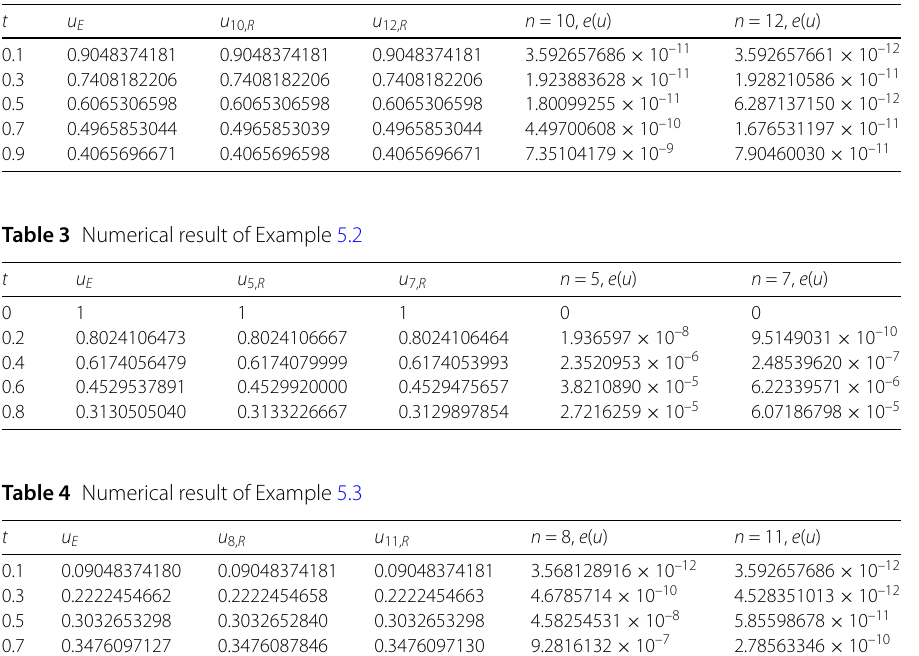
Table 2 Numerical result of Example 5.1